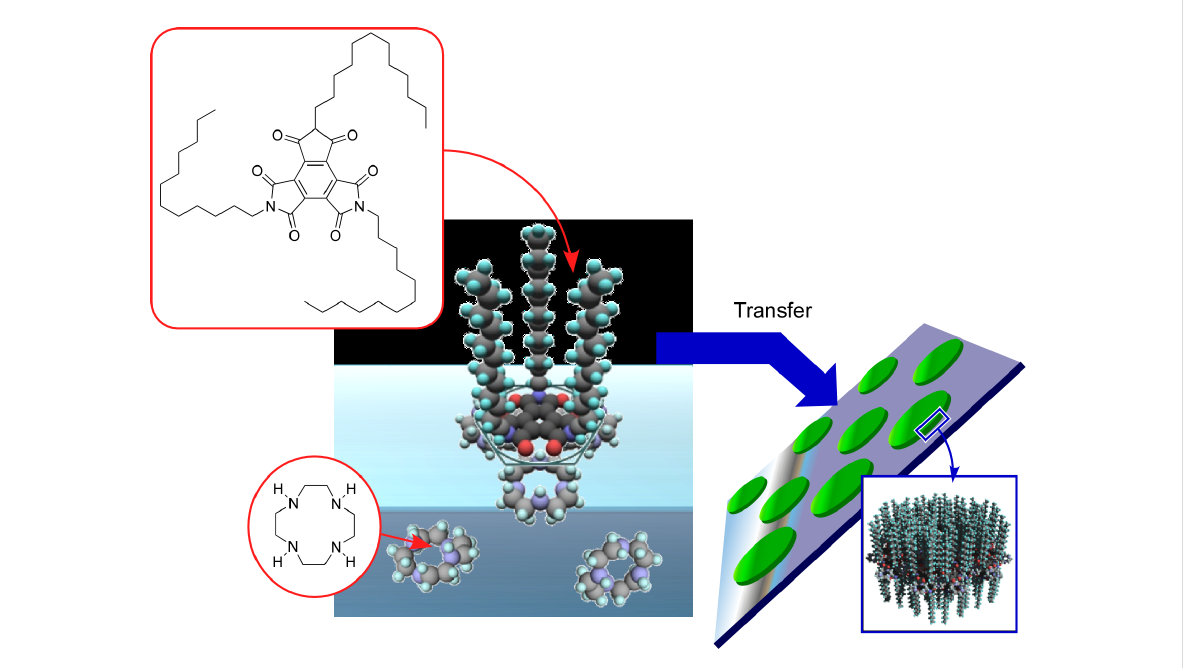
Figure 6: Formation of two-dimensional arrays of nanodisk-like assemblies via touching transfer of a monolayer of amphiphilic tri- n -dodecylmellitic triimide with three alkyl chains as a monolayer component and 1,4,7,10-tetraazacyclododecane (cyclen) as a subphase template. Adapted from [75], copyright 2019 The